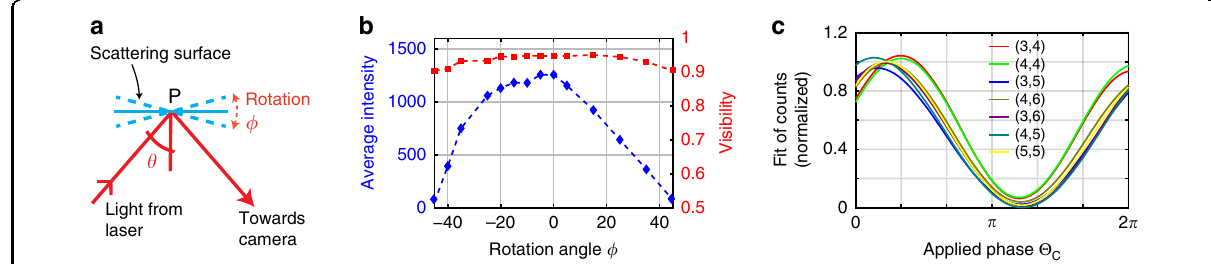
Fig. 3 Visibility with scattered light and coherence among the pixels. a The incident angle θ was varied by rotating the scattering surface about point P by an angle φ from – 45° to + 45° while keeping the position of laser and camera constant. b Variation of visibility and intensity with rotation angle. Here, rotation angle φ = 0° corresponds to incidence angle of θ = 25° as shown in Fig. 1. For rotation angles higher than ±45 0 , suf fi cient amount of photon could not be collected by the camera. The average intensity for each angle is shown on the right axis. The collection time for each data point is 20 s. c Variation of counts versus phases applied at the Converter for the illuminated pixels. Pixel number (1,1) was used as a